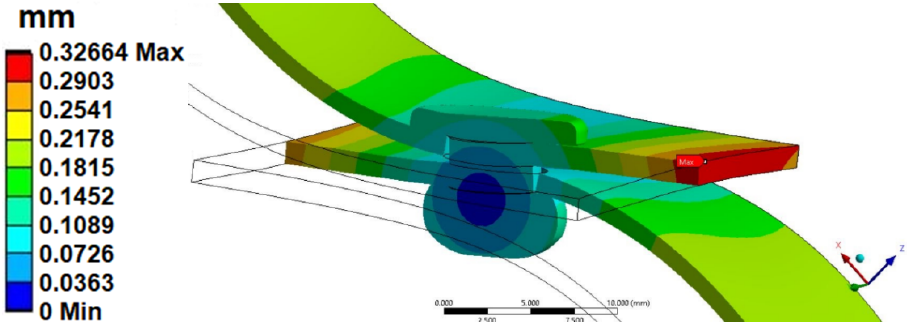
Figure 7. Total deformation of the joint connection of the rivet.